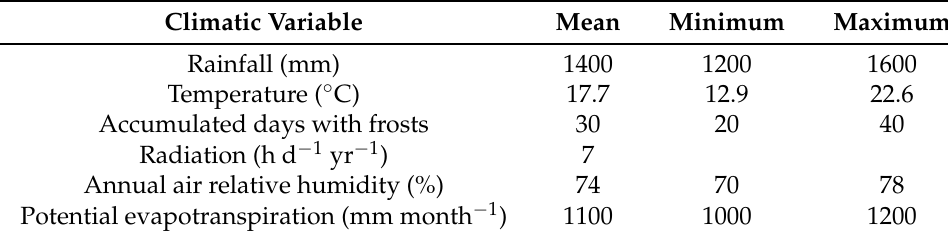
Table 2. Climate characteristics of the northeast region for the period 1980–2009